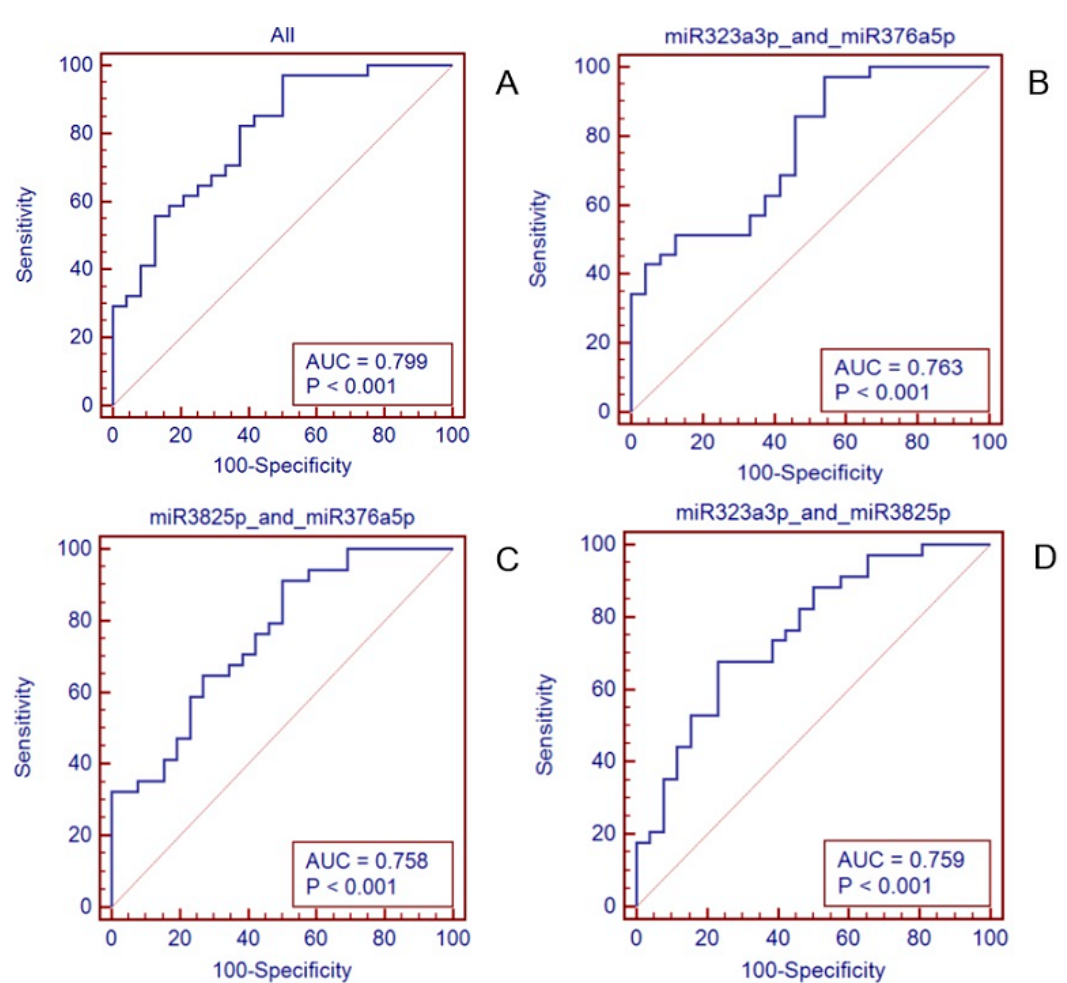
Figure 3. Predictive accuracy of the 3 miRNAs & 2 miRNAs to distinguish patients with LN metastasis from those without LN metastasis. ( A ) 3-microRNA signature (miR-323a-3p, miR-382-5p, miR-376a-3p). ( B ) 2-microRNA signature (miR-323a-3p, miR-376a-3p). ( C ) 2-microRNA signature (miR-323a-3p, miR-382-5p). ( D ) 2-microRNA signature (miR-382-5p, miR-376a-3p).